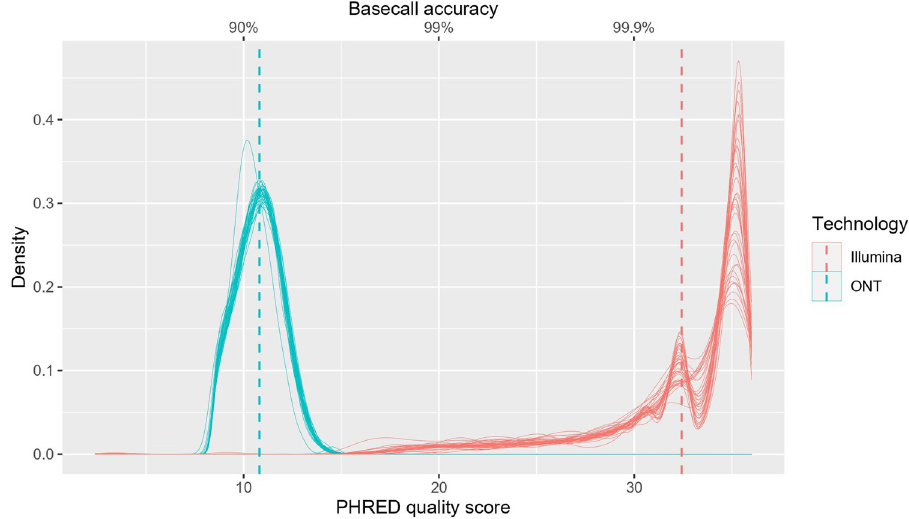
Fig 1. PHRED base call quality score distribution of samples sequenced by Illumina and ONT. Distribution plot of PHRED (probability of error per base call in a log scale) quality score (x axis) and error probability (secondary x axis) derived from the PHRED score for the data set sequenced from Illumina (n = 37) and ONT (n = 37). The scores of ONT are shown in blue and Illumina in red. The mean PHRED scores/error probability are shown with the dashed line for each technology. The mean PHRED scores averaged at 32.35 in Illumina reads and 10.78 in ONT.